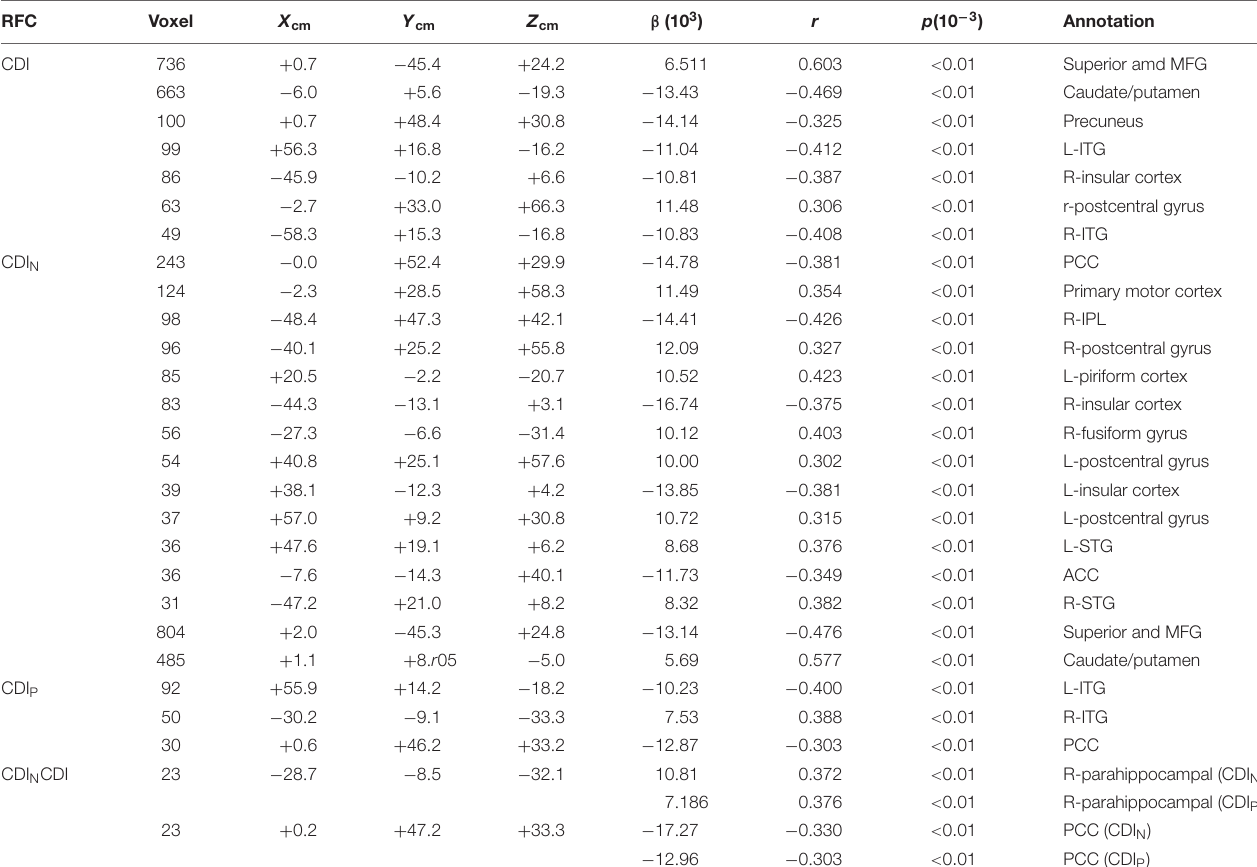
TABLE 2 | The brain regions where the connectivity strength metrics are significantly ( p < 0.05) correlated with the subjects’ ages. RFC Voxel X cm Y cm Z cm β (10 3